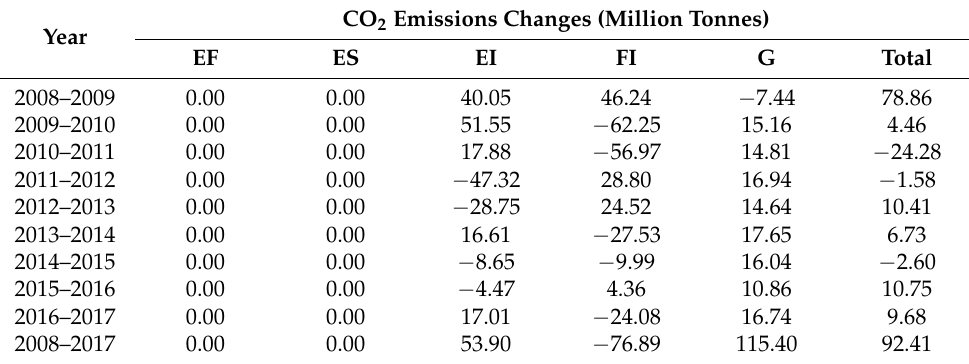
Table 4. Results for the decomposition of the U.S. road freight transport sector.